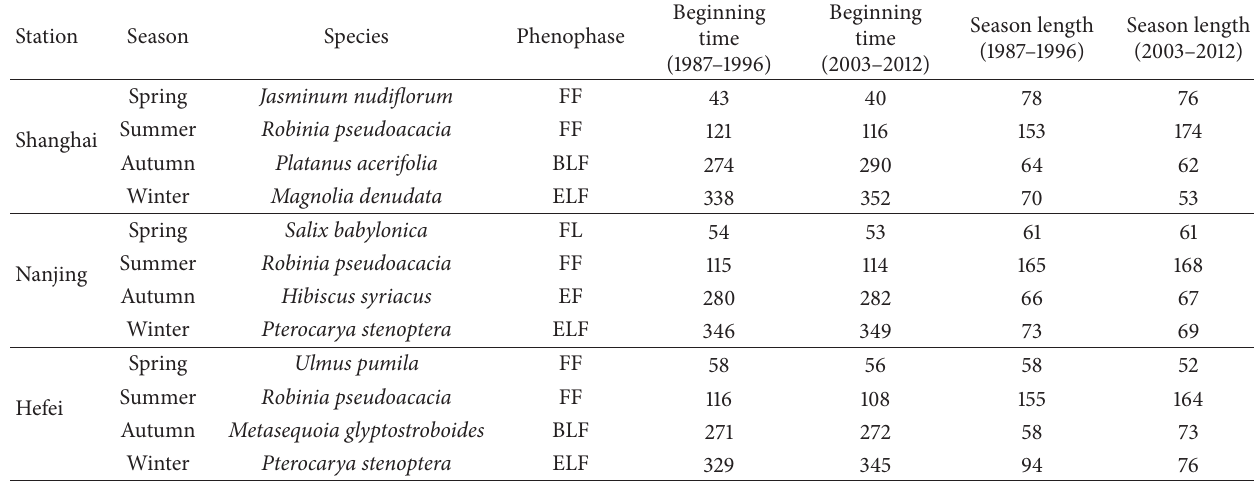
Table 3: Division of phenological seasons for 1987–1996 and 2003–2012.